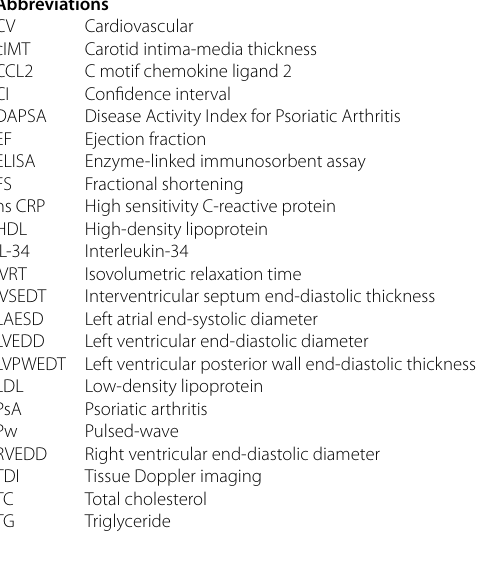
IL-34 interleukin-34, DAPSA Disease Activity Index for Psoriatic Arthritis, cIMT carotid intima media thickness Significant value*: P <